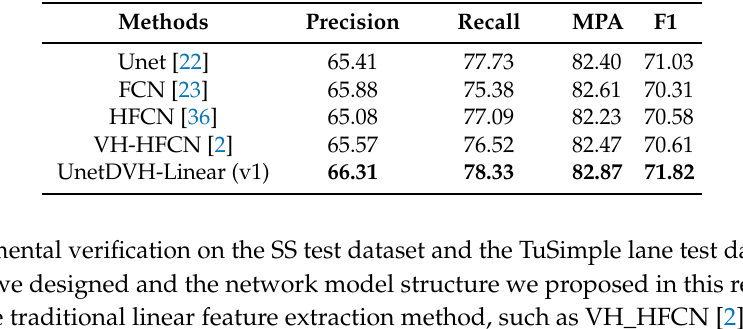
Table 4. Quantitative results of segmentation performance on the TuSimple lane dataset (%).